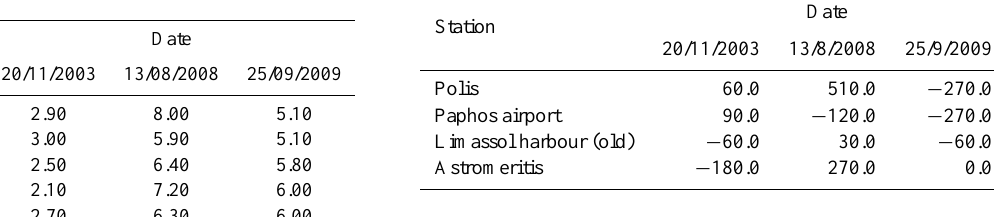
Table 2. ETc using FAO method, remote sensing and meteorolog- ical data at Kokkinochoria irrigated area. The underlined results correspond to the meteorological station that is closest to the irri- gated area of interest.